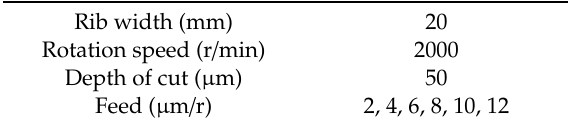
Table 6. Machining condition of micro cutting to optimize the